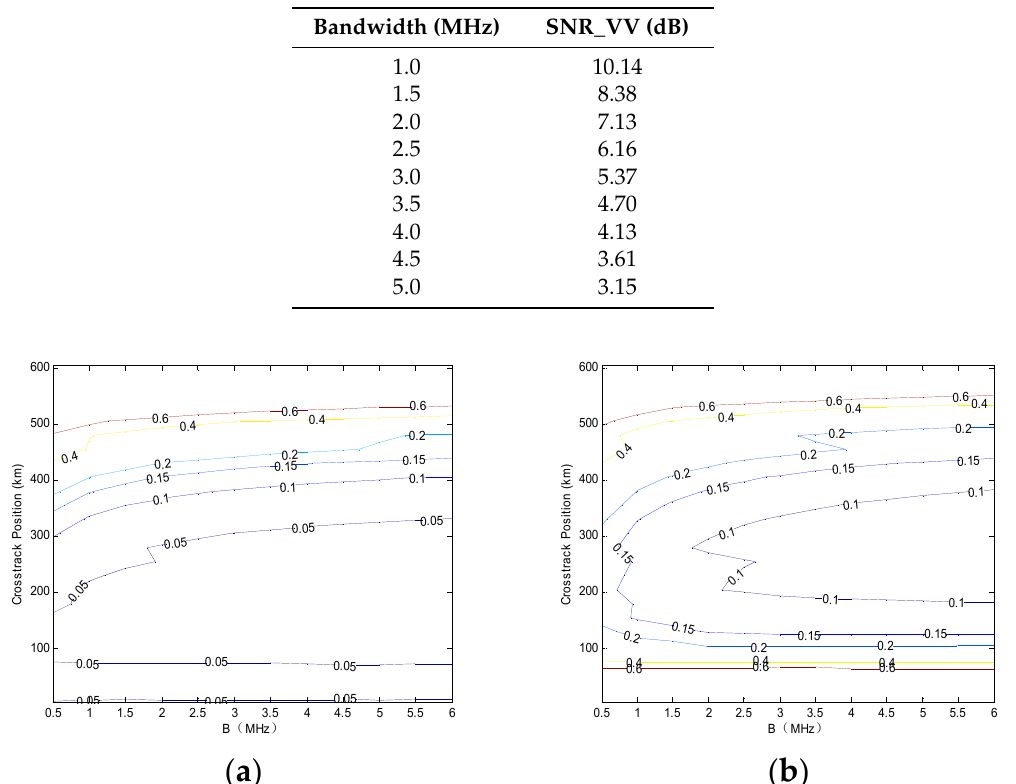
Table 5. Signal-to-noise ratio (SNR) with different bandwidths.